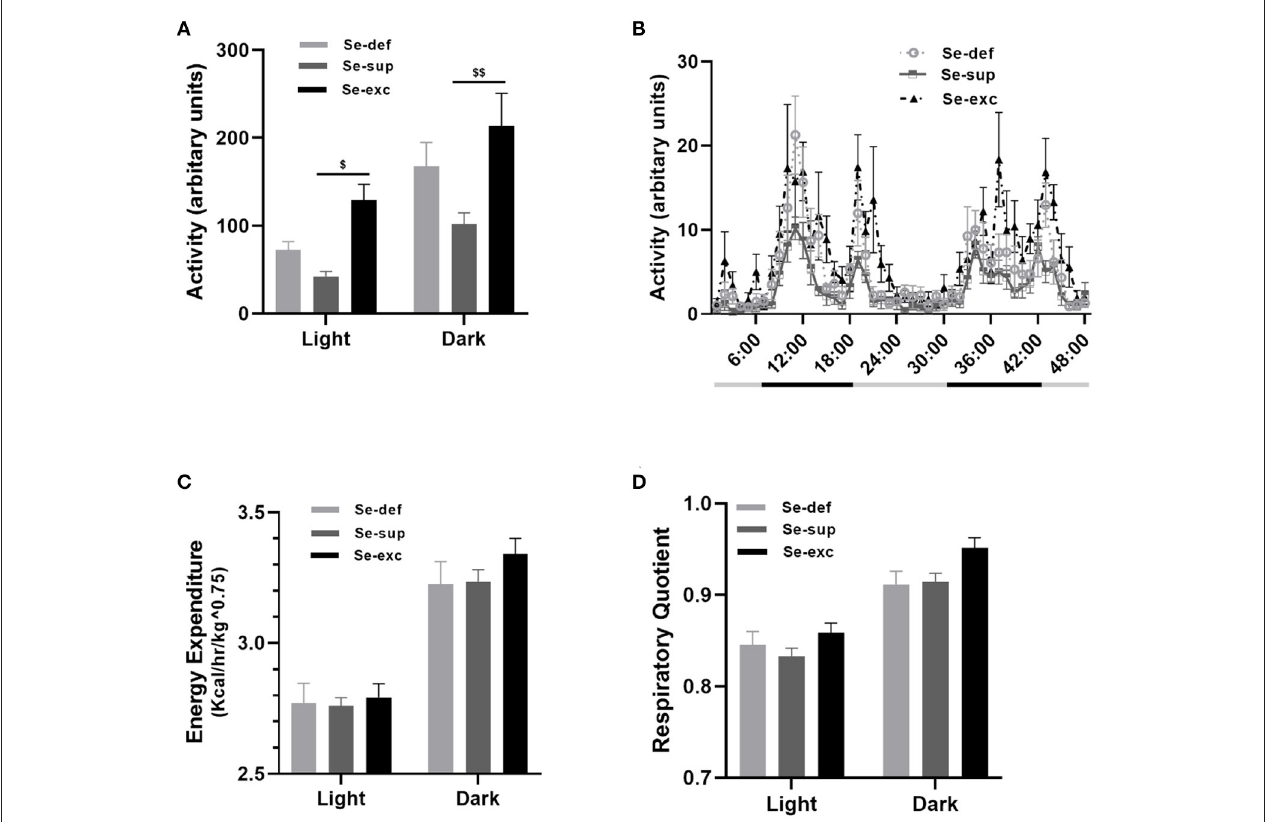
FIGURE 4 | Influence of varying Se supplementation on locomotion and respiratory metabolism. (A) Mean ( ± SEM) locomotor activity during the light and dark cycles. (B) 48-h time course of locomotor activity. (C) Mean ( ± SEM) energy expenditure during the light and dark cycles. (D) Mean ( ± SEM) respiratory quotient during the light and dark cycles. $ p < 0.05 between Se-exc and Se-sup groups; $$ p < 0.01 between Se-exc and Se-sup groups; ( n = 6–7 animals per group for all